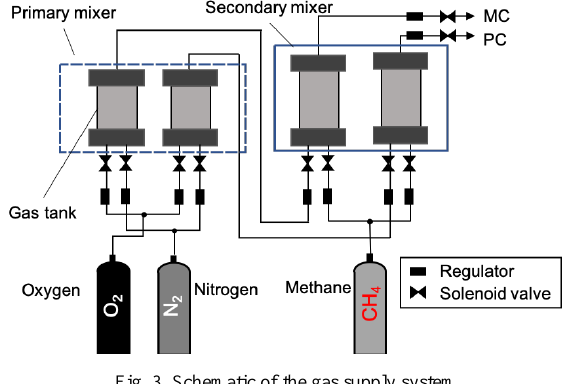
Fig. 3. Schematic of the gas supply